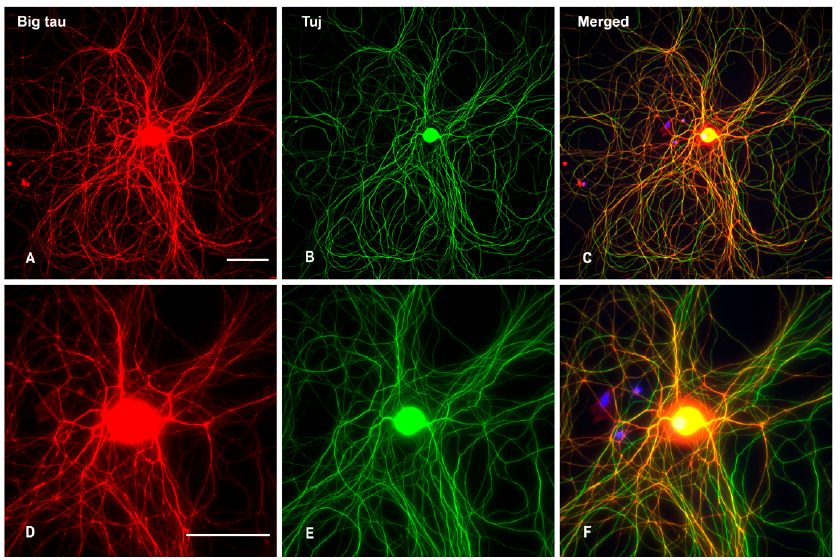
Figure 7. Cultured SCG (P28) stained with Big tau and Tuj. SCGs dissociated from P28 and cultured for 7 days show big tau expression ( A ) in both cell body and neurites, which co ‐ localized with Tuj ( B , C ). ( D – F ) are higher magnification images corresponding to images ( A – C ) above. Scale bar = 100 µ m, for all